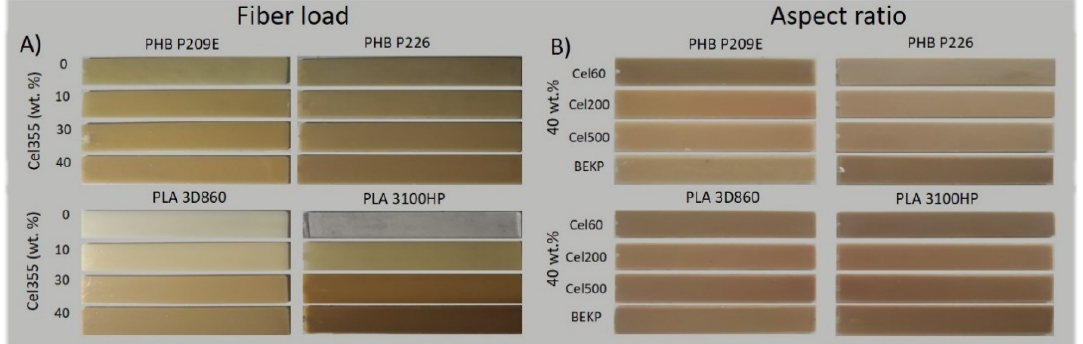
Figure 2. Digital photographs of the PHB- and PLA-based composites with: ( A ) different Cel355 loads (0, 10, 30 and 40 wt.%), and ( B ) with micronized fibers with distinct aspect ratios and non-micronized BEKP fibers.